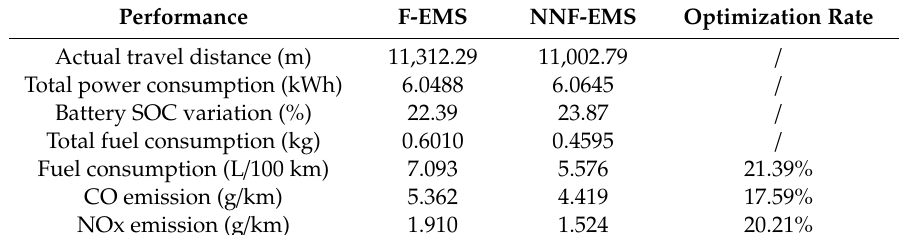
Table 3. Comparison of fuel economy and emission performance under NEDC cycles.